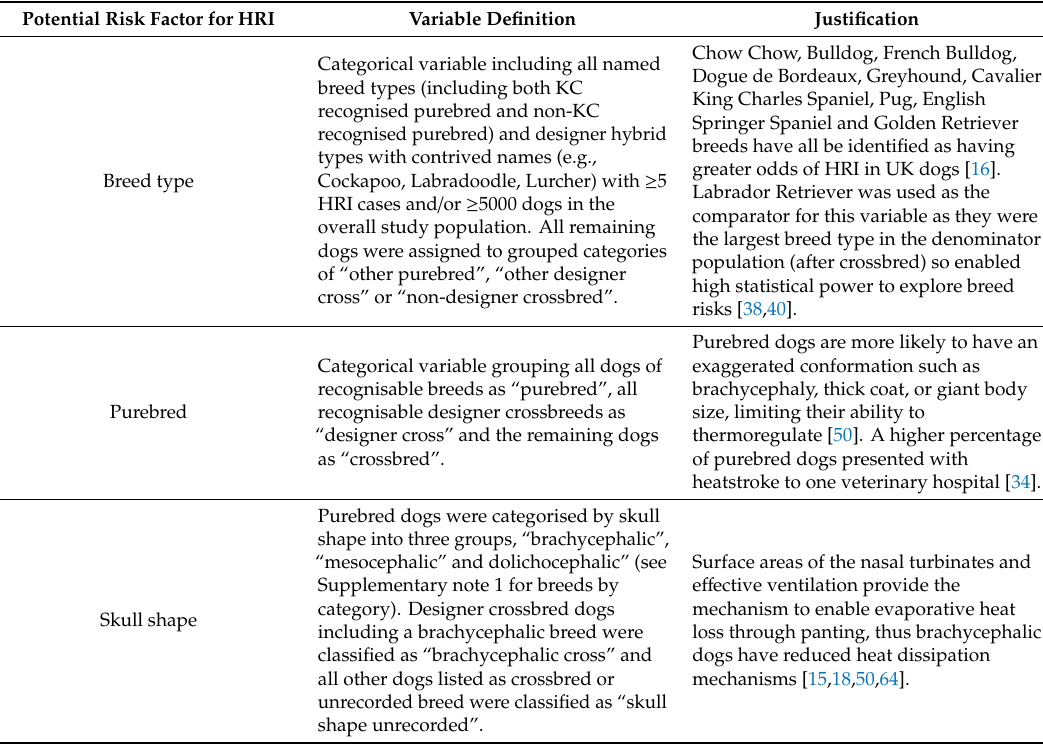
Table A1. Potential canine risk factors for association with HRI in UK dogs